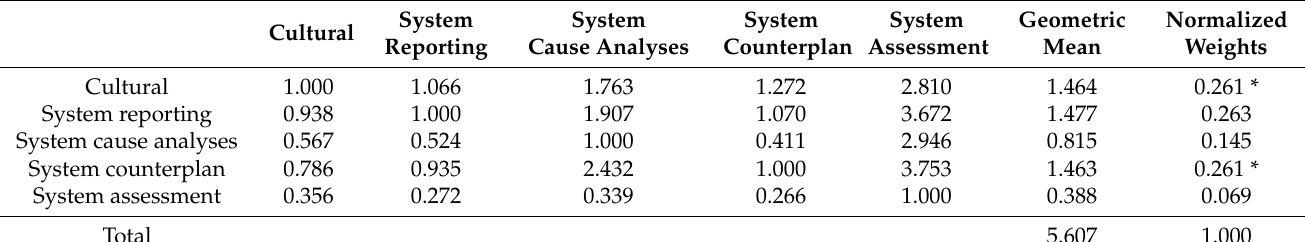
Table 3. Integrated matrix and normalized weights of criteria.